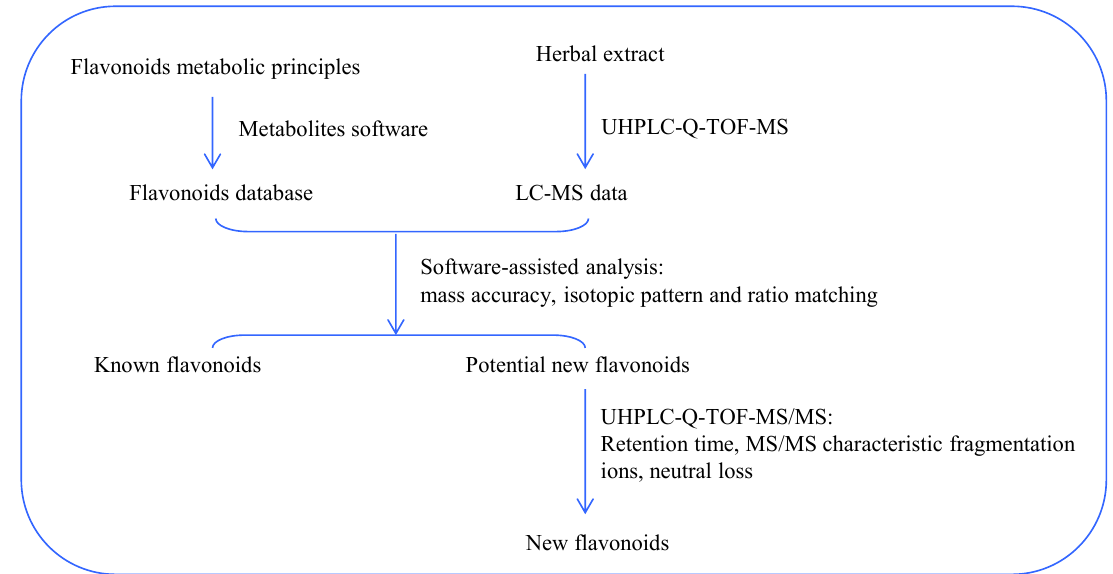
Figure 3. Flow chart of metabolites software-assisted flavonoids hunting in Smilax glabra